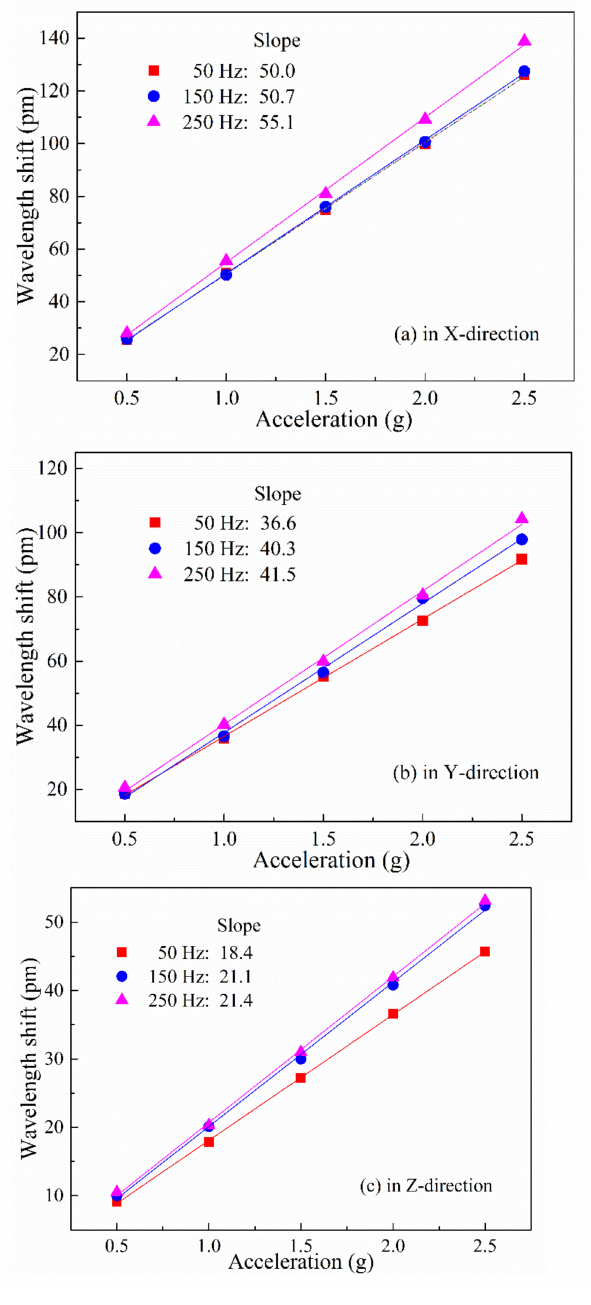
Figure 20. Wavelength shift of accelerometer as a function of acceleration amplitude in the ( a ) x-, ( b ) y-, and ( c )